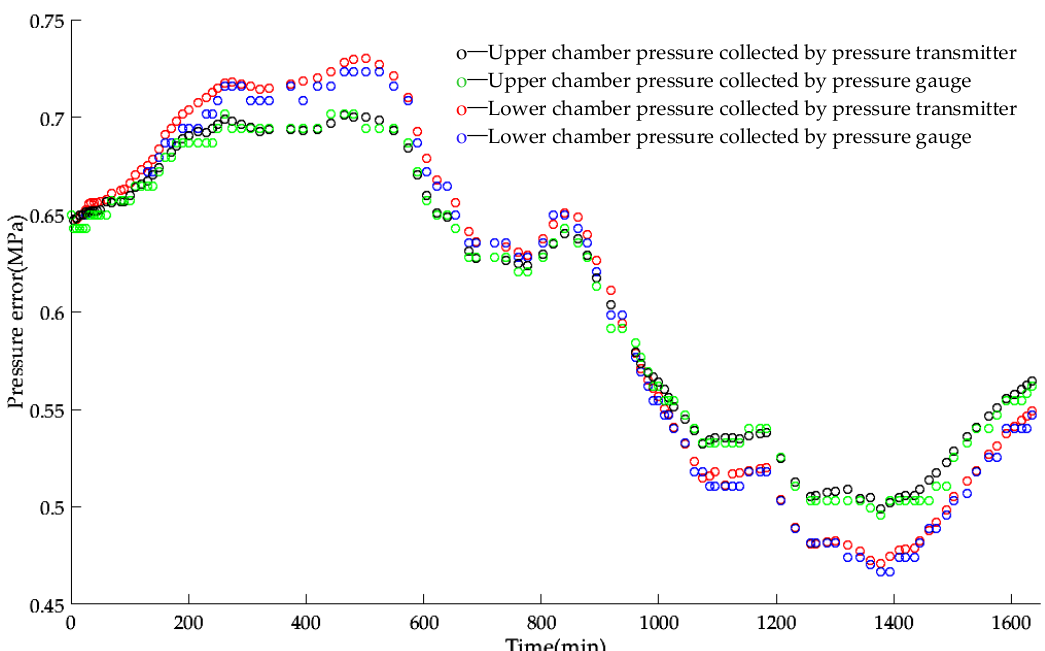
Figure 10. Data measured by electronic pressure transmitter and mechanical pressure gauge.